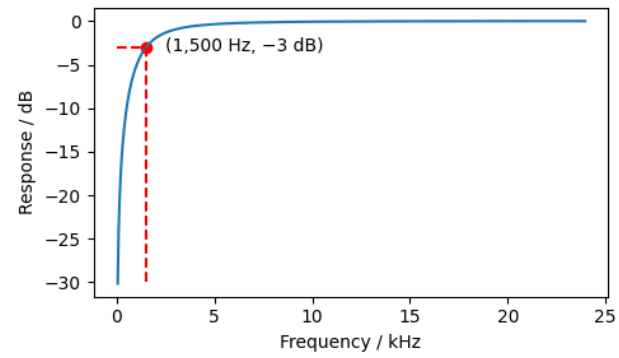
Figure 4. The frequency response of the filter.